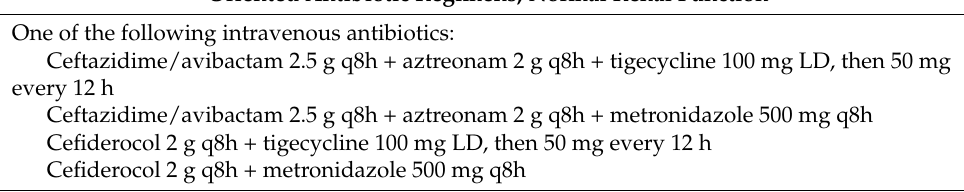
Table 6. Patients with IAIs with known colonisation (infection) by MBL-producing Enterobacterales . Oriented Antibiotic Regimens; Normal Renal Function